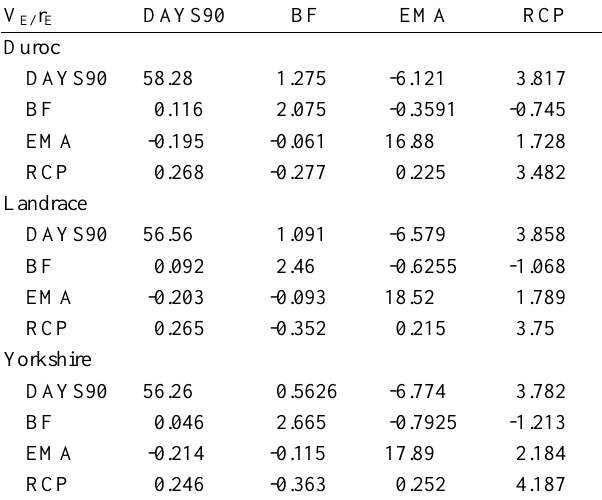
Table 4. Environmental variances (diagonals), covariances (above diagonals), and environmental correlation coefficients (below